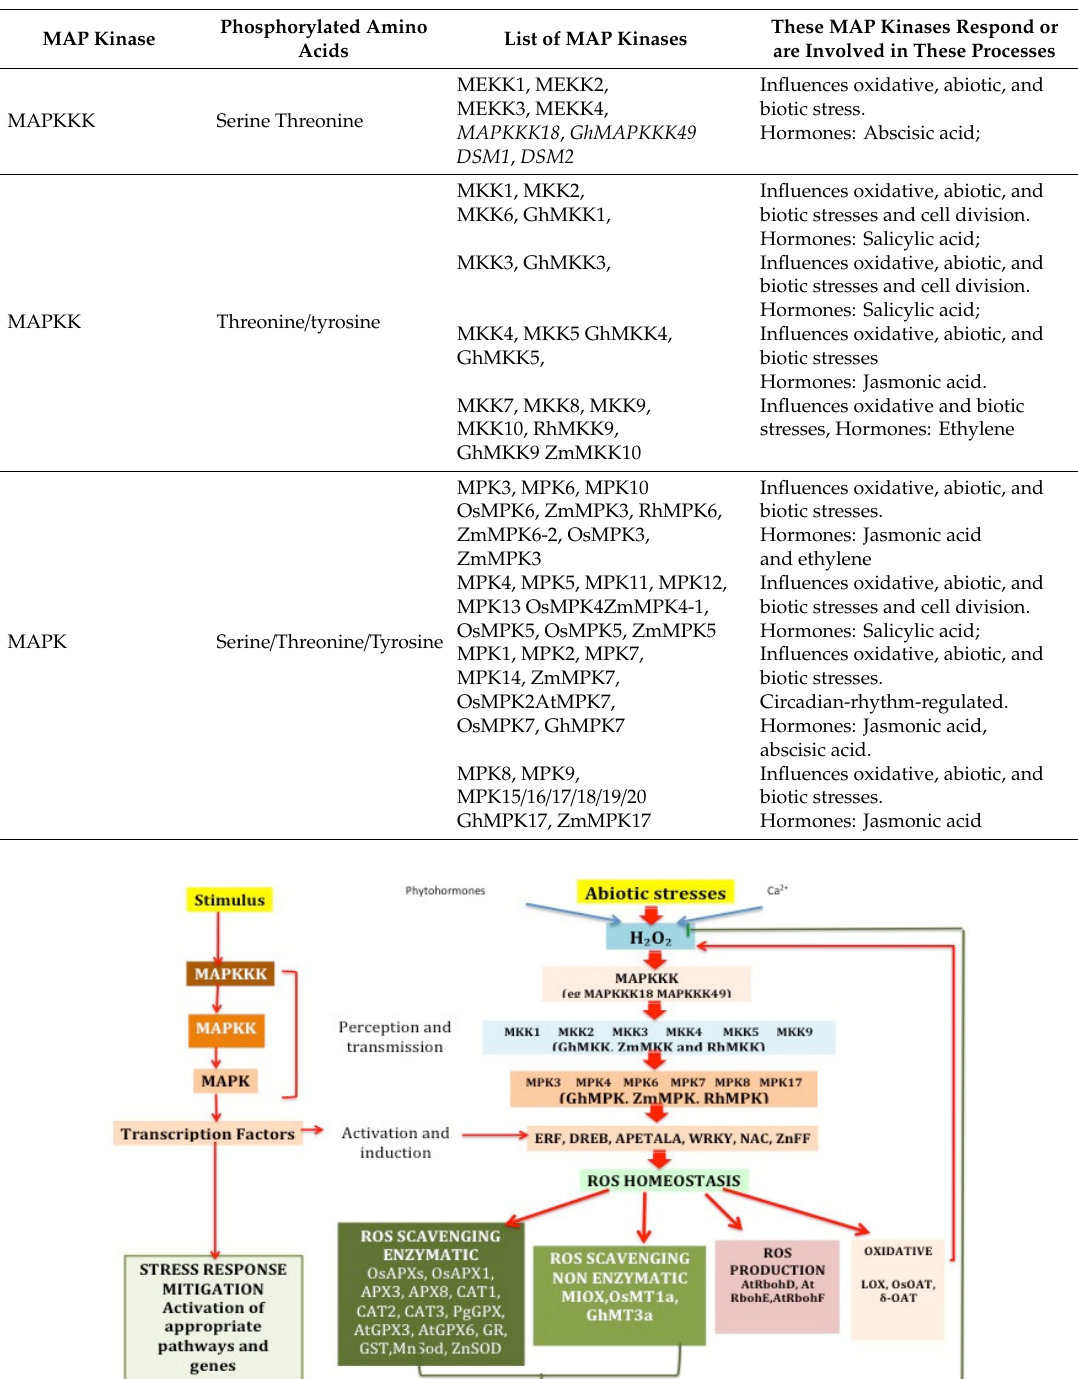
Table 1. List of mitogen-activated protein (MAP) kinases and the processes they are implicated to regulate.